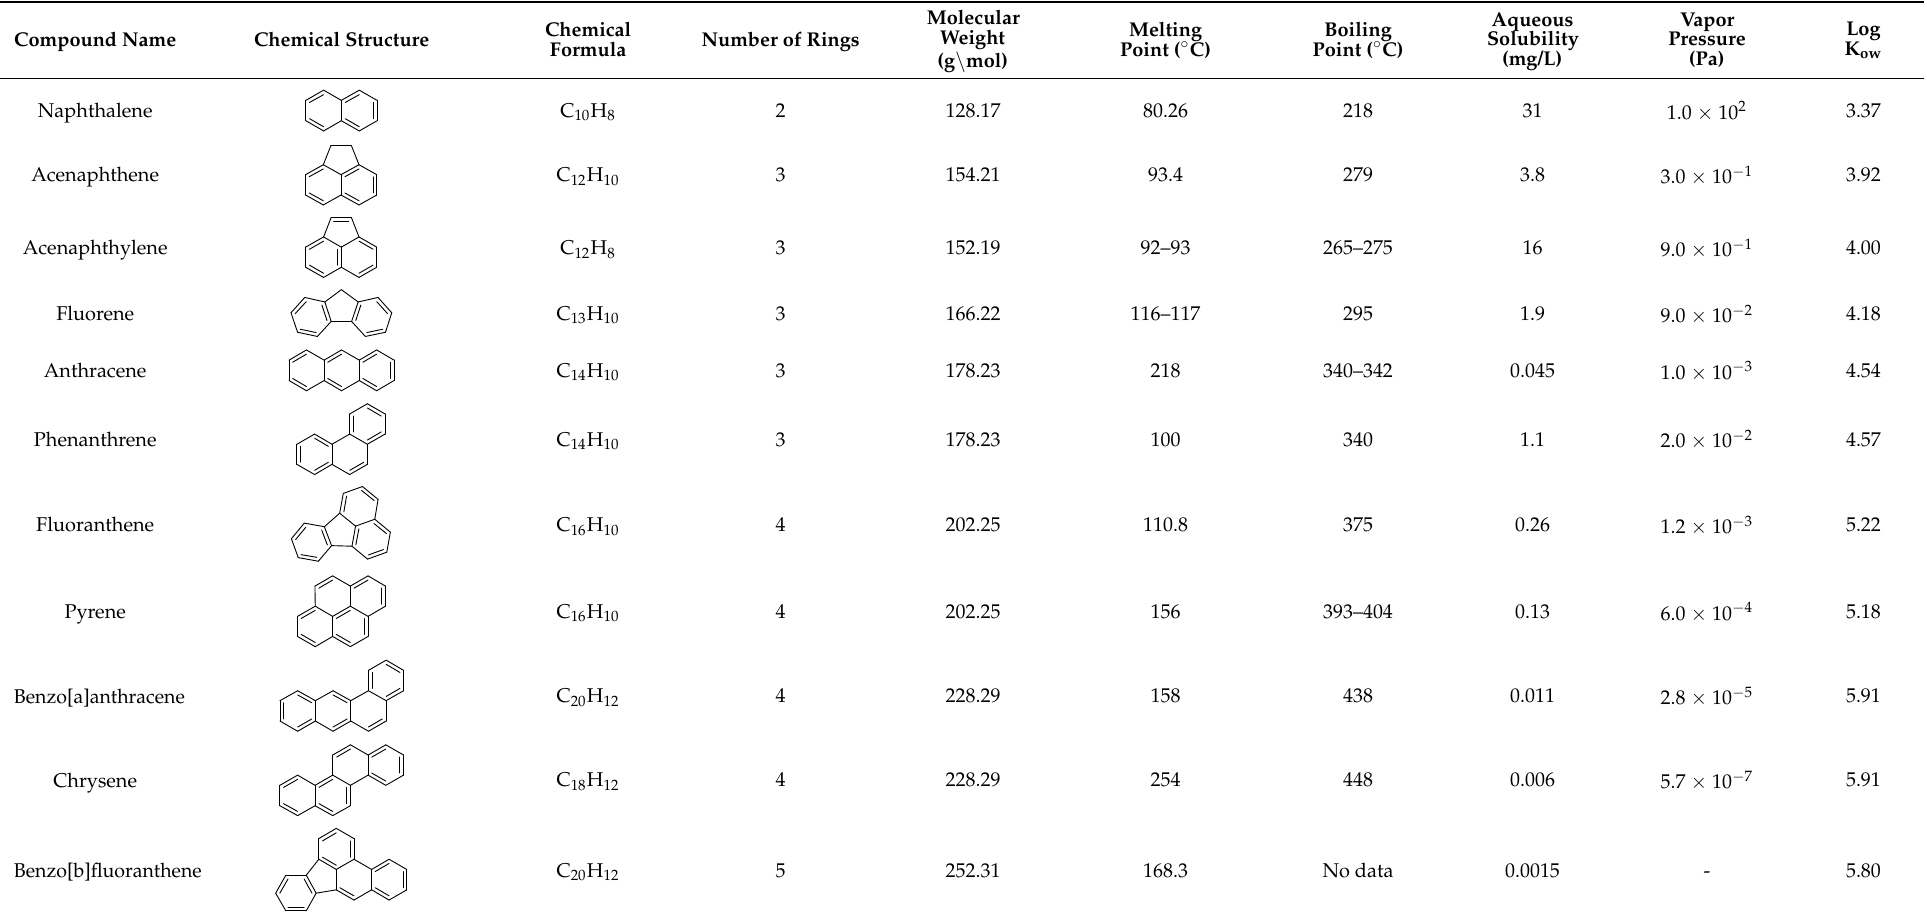
Table 1. Physiochemical properties of the 16 U.S. Environmental Protection Agency (EPA) PAHs [53,72,73].